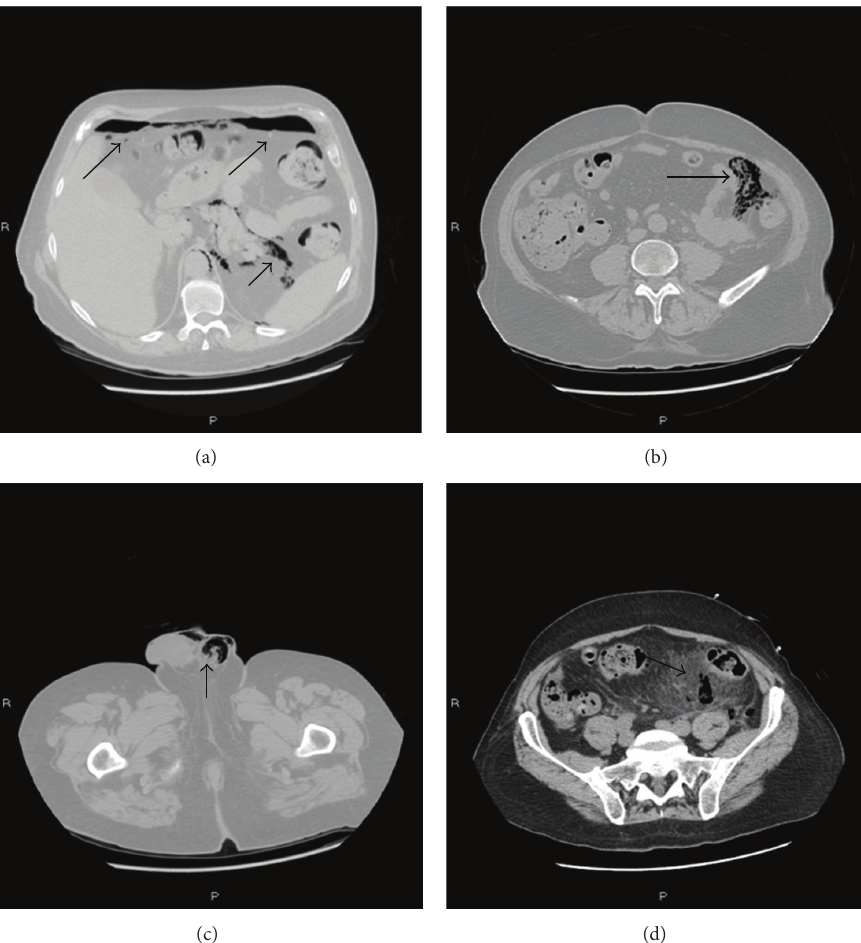
Figure 1: The first abdomen CT scan revealed free gas in correspondence of anterior subdiaphragmatic region (a) and left parietocolic shower (b).Gaswasvisualizedwithinthescrotalsac(pneumoscrotum)(c).Peritonealfatstrandingandinflammatorychangesareobserved(d)(black